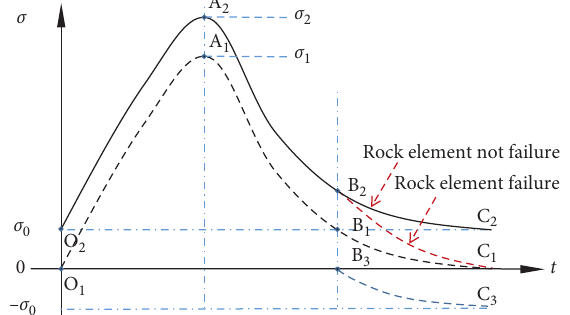
Figure 11: Loading and unloading curves under the combination of in situ stress and blast